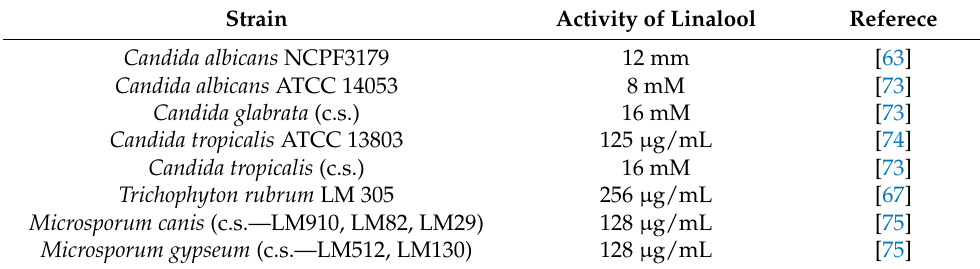
Table 6. Antimicrobial activity of linalool against fungi. Strain Activity of Linalool Referece Candida albicans NCPF3179 12 mm [63] Candida albicans ATCC 14053 8 mM [73] Candida glabrata (c.s.) 16 mM [73] Candida tropicalis ATCC 13803 125 µ g/mL [74] Candida tropicalis (c.s.) 16 mM [73] Trichophyton rubrum LM 305 256 µ g/mL [67] Microsporum canis (c.s.—LM910, LM82, LM29) 128 µ g/mL [75] Microsporum gypseum (c.s.—LM512, LM130) 128 µ